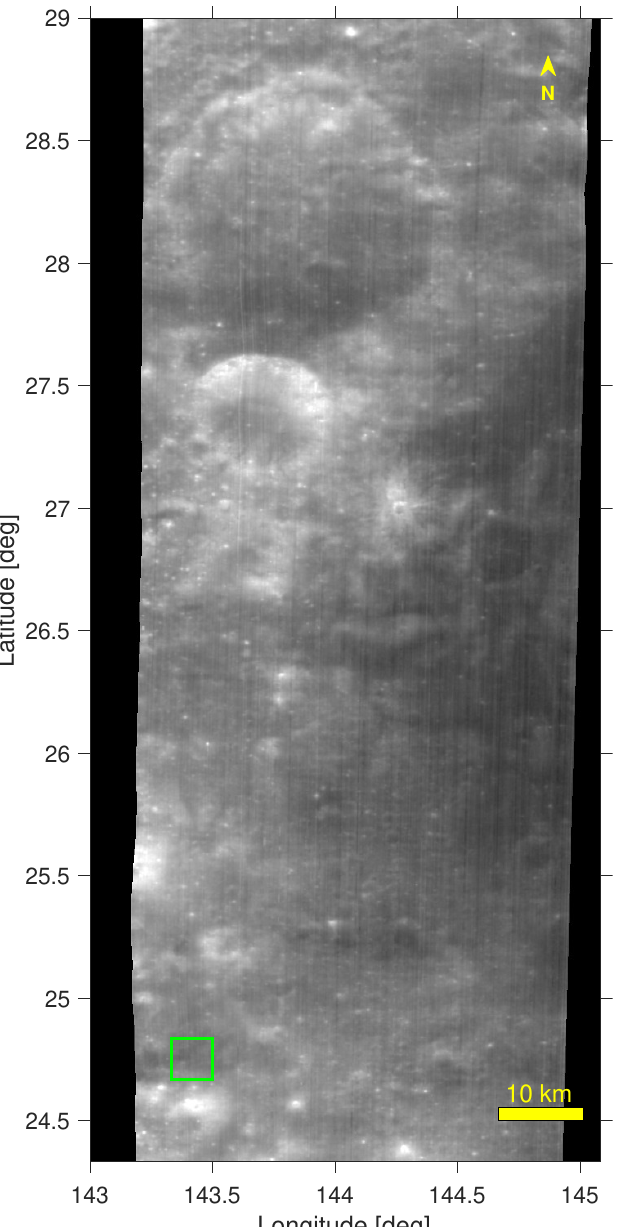
available. In the late lunar morning, at 09:20 (image M3G20090125T172601) local time, it can be assumed that the weakly bound OH/H 2 O component is still partially present due to the moderately high latitude (see Grumpe et al. [7], compare Figures 22 and 23 for region 17 therein). At the acquisition time of the second image, at lunar midday at around 11:15 (image M3G20081229T101650), Grumpe et al. [7] argued that the weakly bound OH/H 2 O component is diminished and only the strongly bound OH/H 2 O component remains.